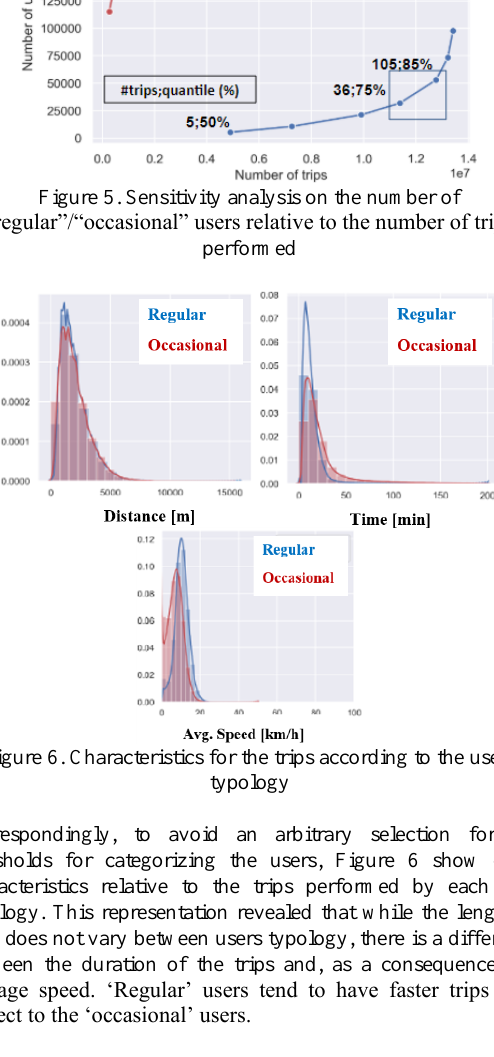
Figure 7. Hourly trips count during the week based on day and user typology (regular users)